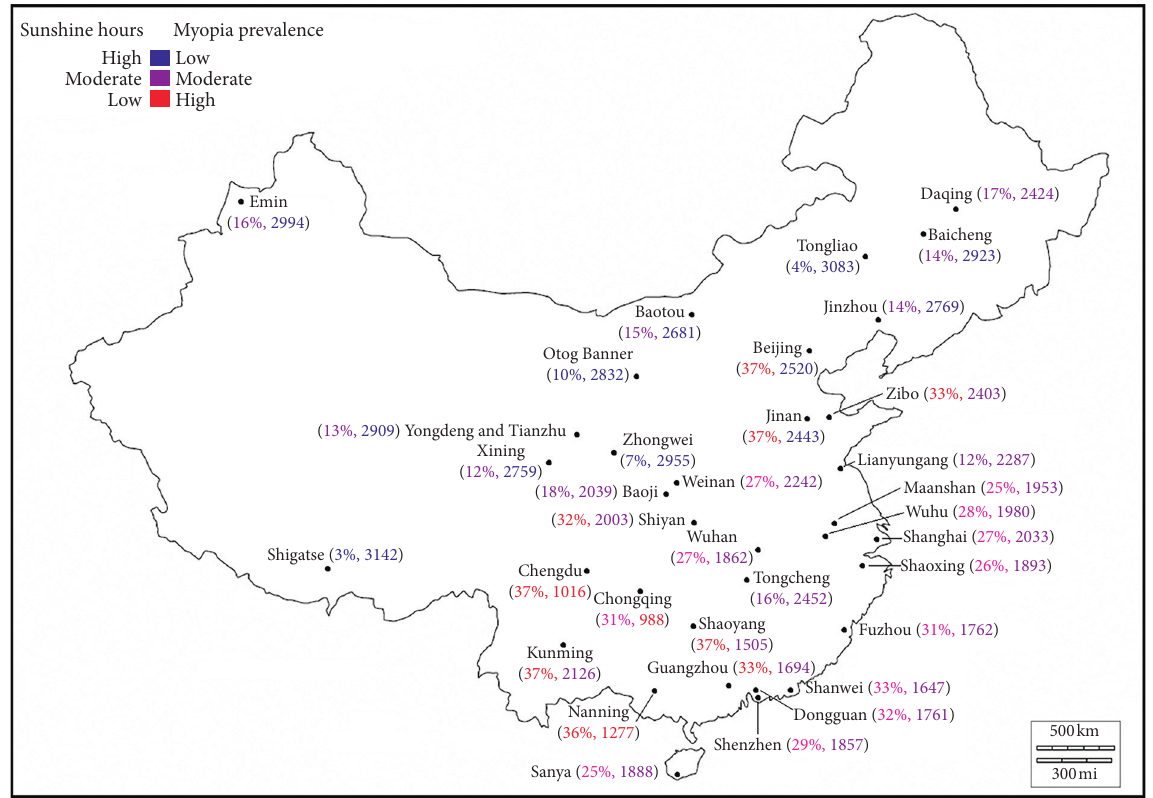
Figure 3: Myopia prevalence in primary schoolchildren and mean annual sunshine hours in mainland China. Blue colour font indicates regions with lower myopia prevalence and higher annual sunshine hours. Red colour font indicates regions with higher myopia prevalence and lower annual sunshine